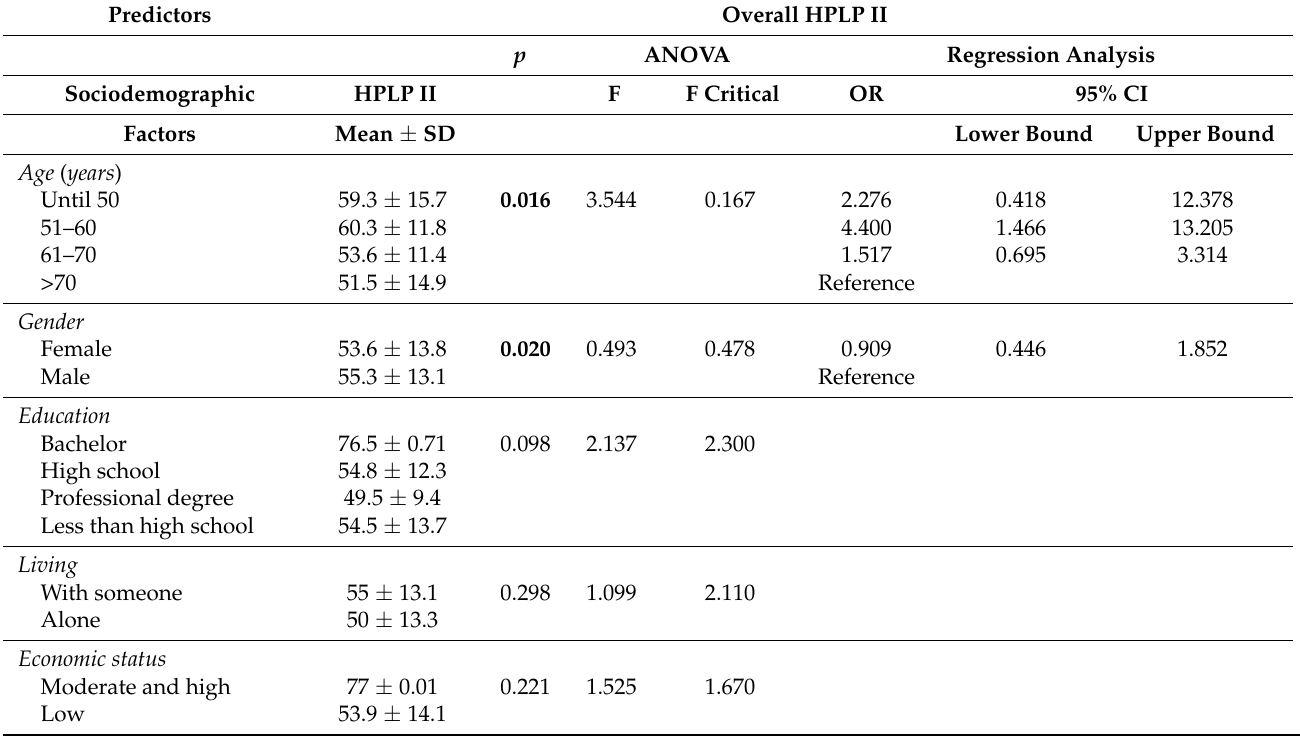
Table 3. Association between health promoting lifestyle and sociodemographic